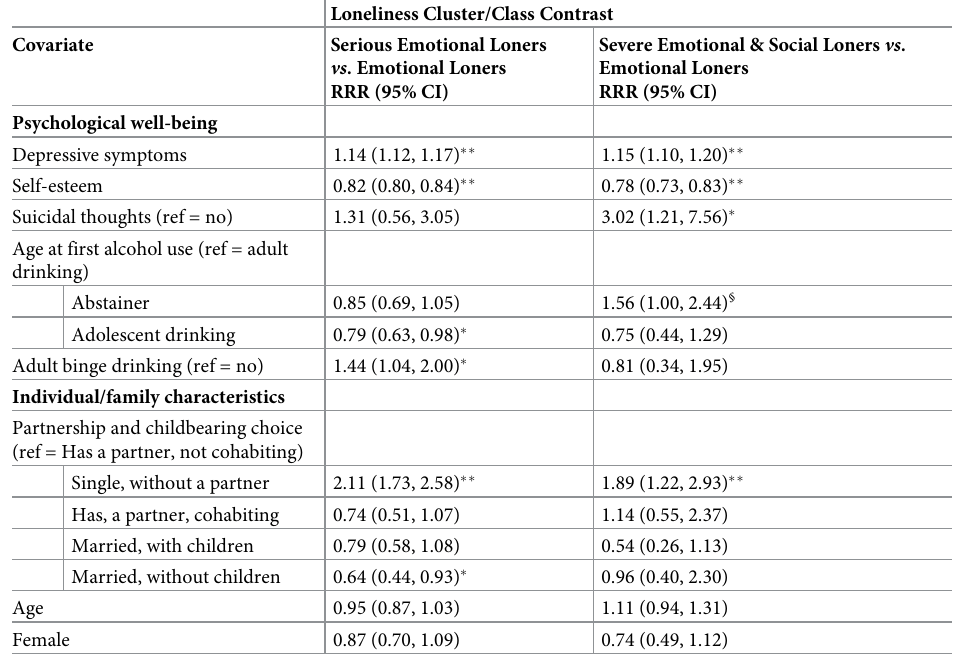
Table 3. Multivariate multinomial logistic regression results for latent structure of loneliness among young adults, N =